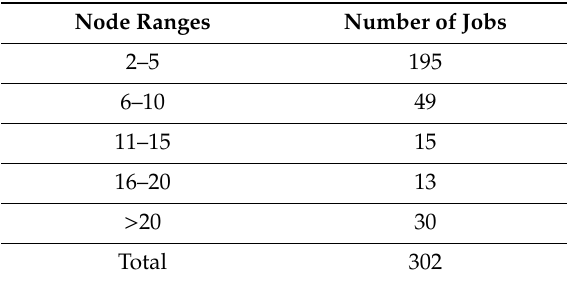
Table 3. The number of nodes per job